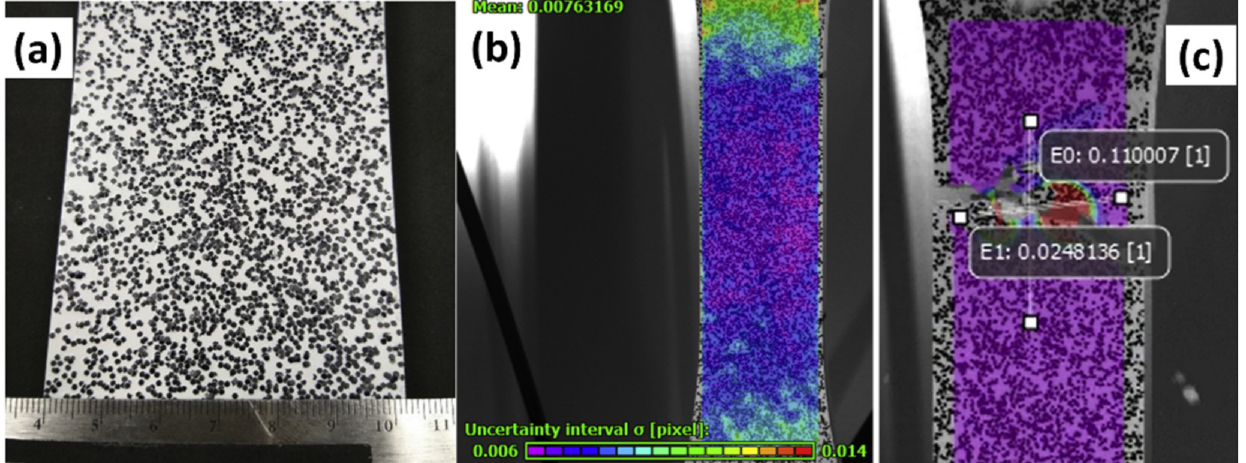
Figure 28. ( a ) Speckle pattern applied on the tensile test specimen. ( b ) Uncertainty in the correlation of subsets in images. ( c ) Virtual extensometers were placed on the fracture site